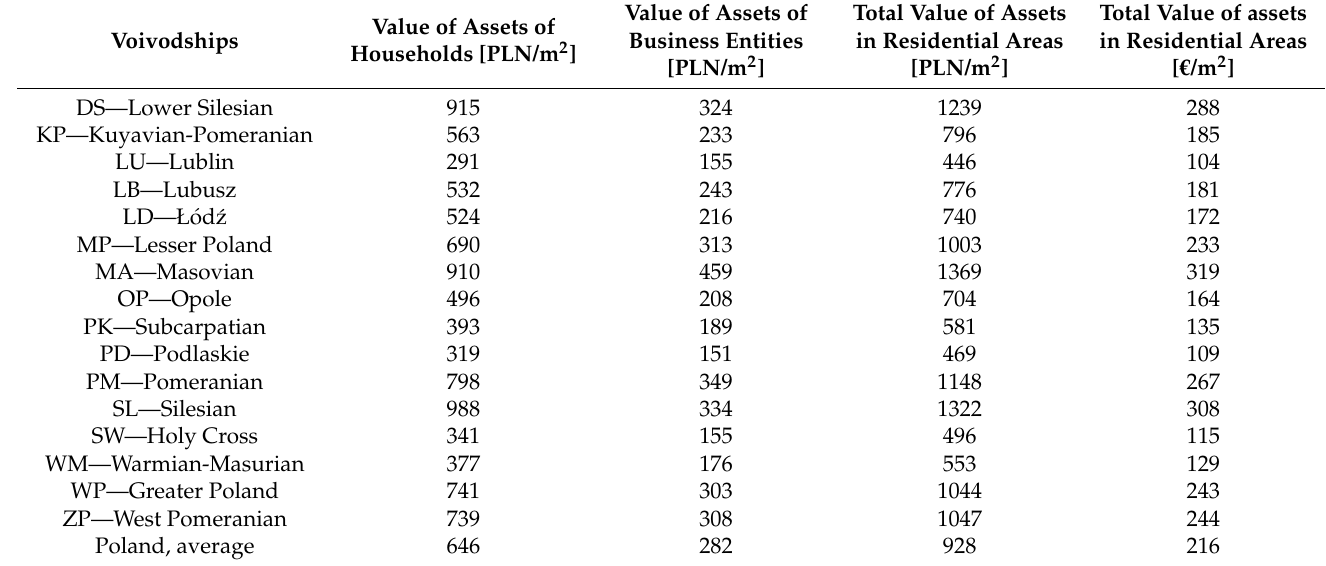
The final results of the calculations are the total values of assets in residential areas, including both household assets (buildings with contents and vehicles) and assets of business entities (fixed assets and stocks) (Table 6). Table 6. Value of assets in residential areas in 16 voivodships (in 2019